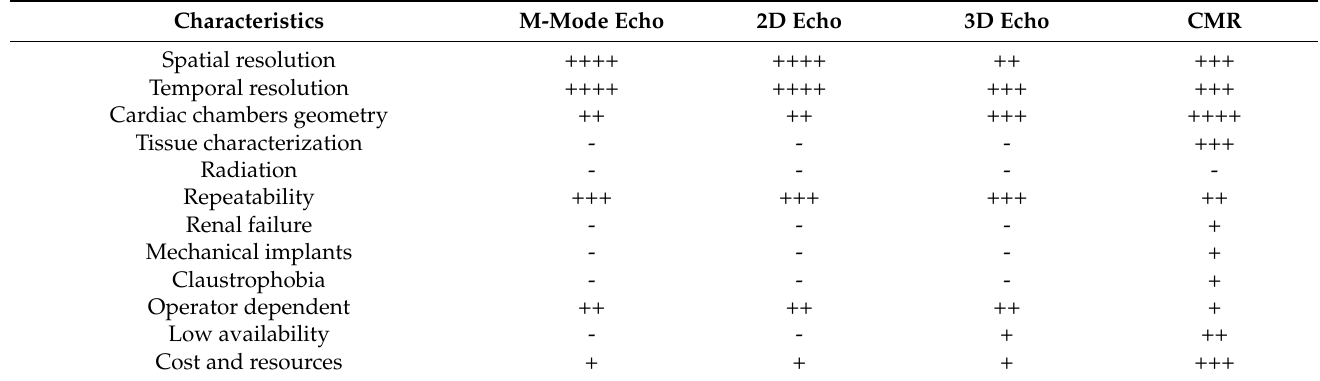
Table 1. Comparison of imaging modalities used for the estimation of left ventricular hypertrophy.